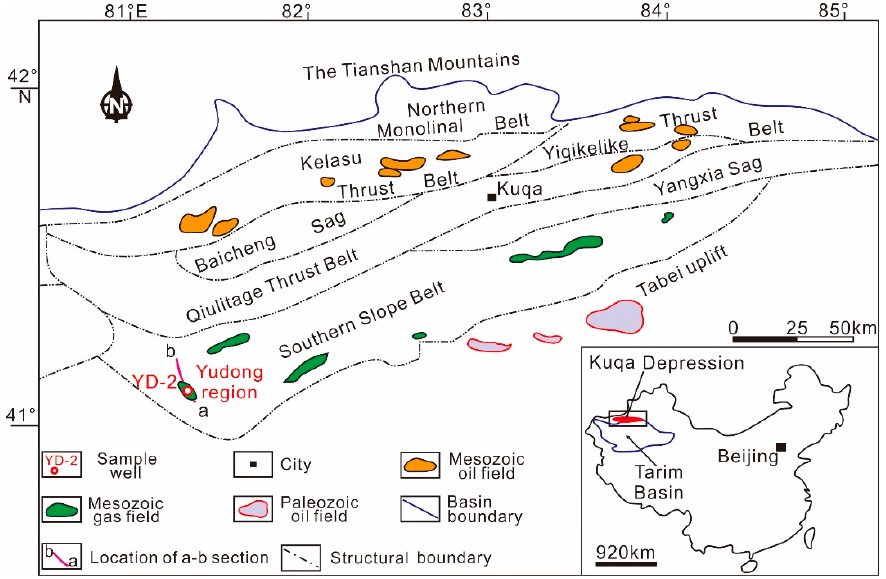
Figure 1. Drillhole YD-2 is located in the Southern Slope Belt of the Kuqa Depression in the Tarim Basin, NW China. The inset shows the locations of the Kuqa Depression and the Tarim Basin in China. (modified after [23]).